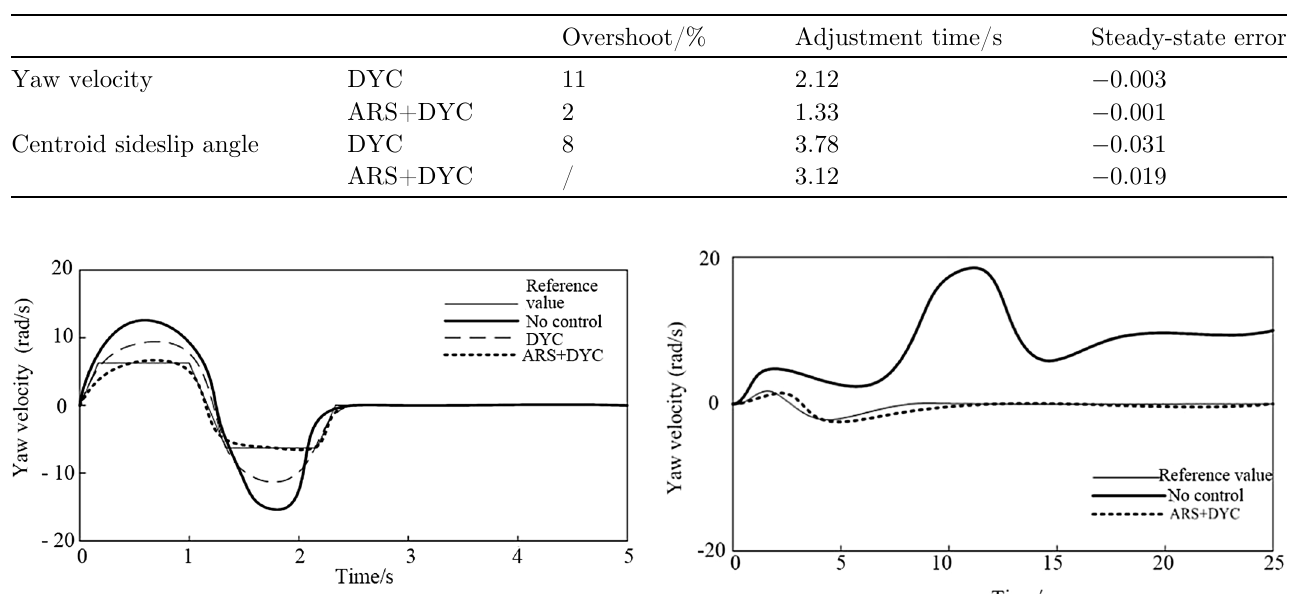
Table 2. Control performance.